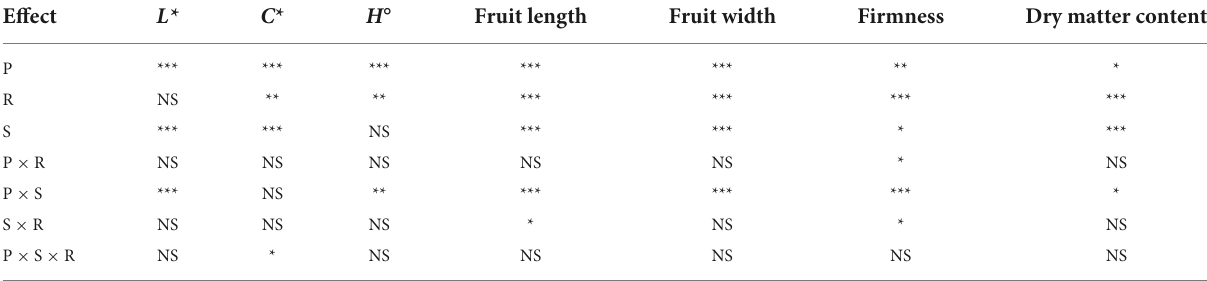
TABLE 1 Analysis of variance of the effects of planting season (Spring and Fall), rootstock (‘DR0141TX’, ‘Estamino’, ‘RST-04-106-T’, ‘Shield’, and the non-grafted scion controls), and scion (grape tomato ‘BHN 1022’ and beefsteak tomato ‘Skyway’) on tomato fruit C * (chroma), L * (lightness), and H ◦ (hue angle) values, length, width, firmness, and dry matter